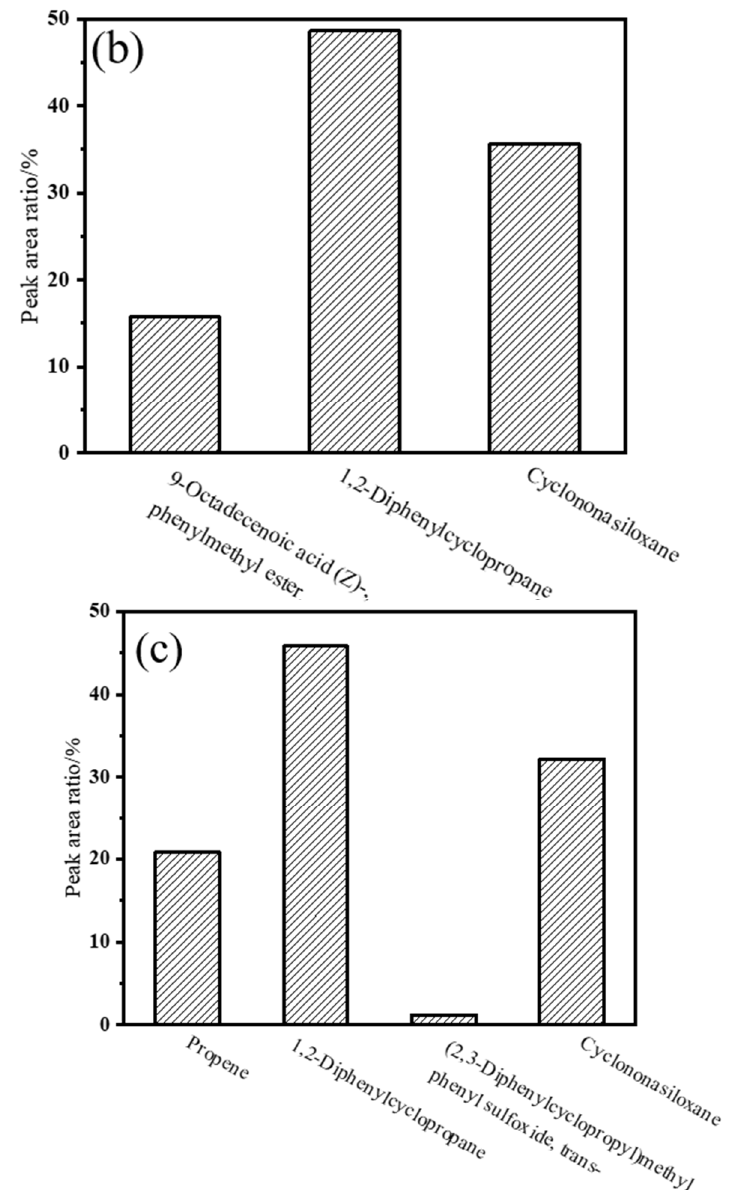
Figure 4. Composition of macromolecular organic gas pollutants during thermal desorption of simulated polluted soils under pure N 2 atmosphere at 600 ◦ C. ( a ) A1, sample of 1 mL waste oil mixed with 25 g soil; ( b ) A2, sample of 2 mL waste oil mixed with 25 g soil; ( c ) A3, sample of 3 mL waste oil mixed with 25 g soil.